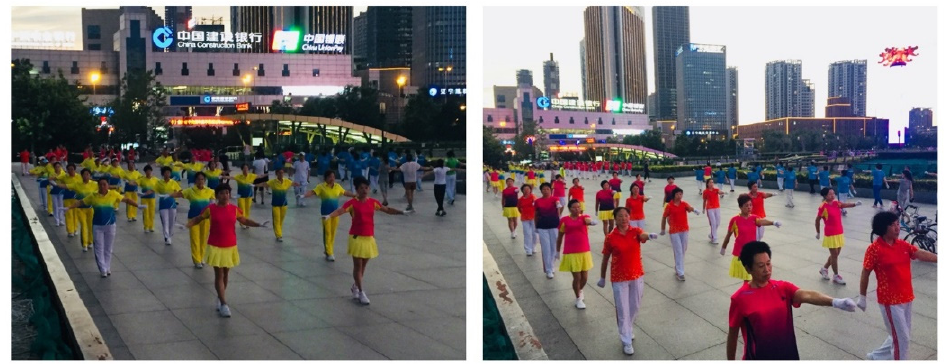
Figure 2. Image illustrating square sports through allocated places.